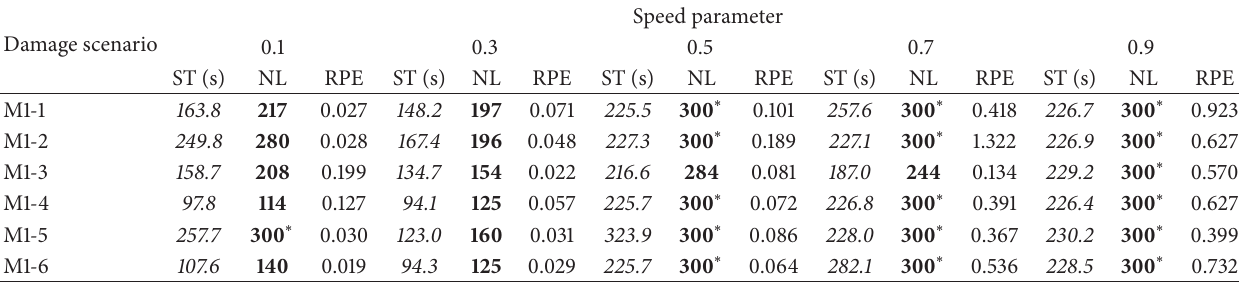
Table 5: Solution time, loops, and RPE of FD method for model